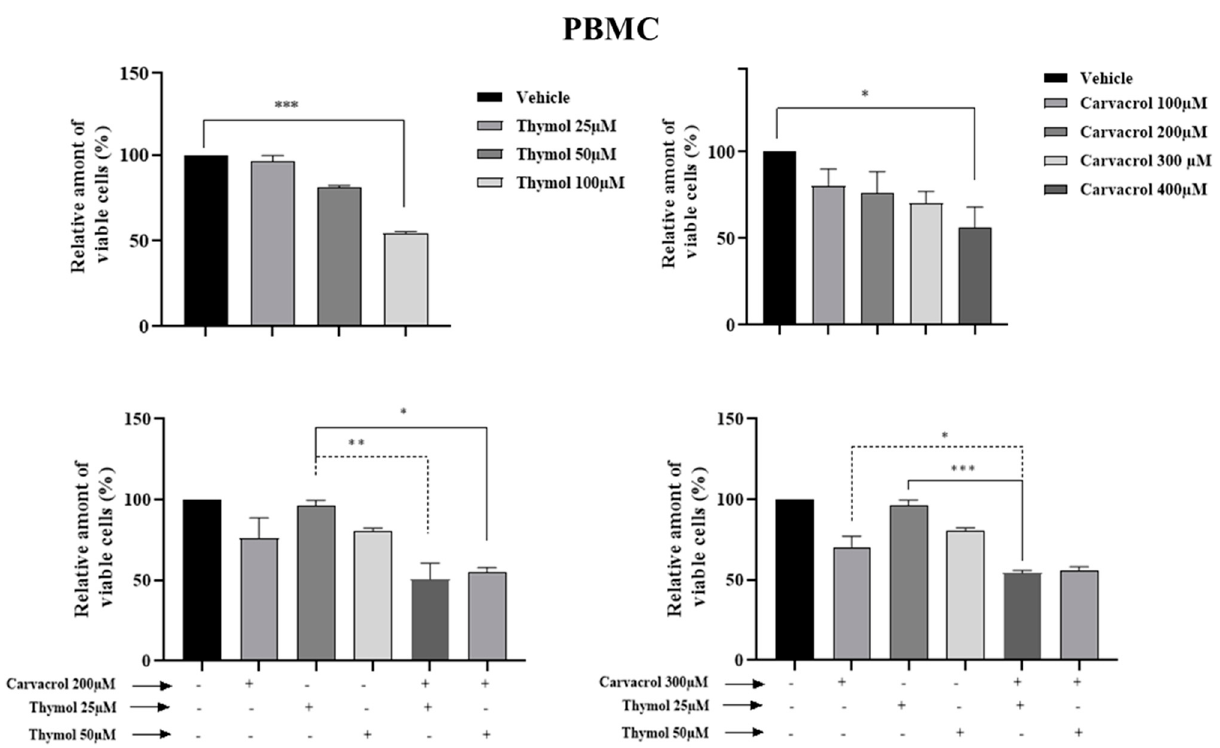
Figure 6. Impact of carvacrol, thymol, and their combination on the viability of the peripheral blood mononuclerar cells (PBMCs) from healthy donors. Flow cytometric analysis of cell death with AnnexinV-FITC/PI double staining after two 48 h treatments with different concentrations of carvacrol and thymol (individually or in combination). Data were analyzed by Kaluza software 2.1. Data represent the mean ± SEM of three independent experiments relative to vehicle. The levels of statistical significance were set at p < 0.05 (*), p < 0.01 (**) and p < 0.001 (***).